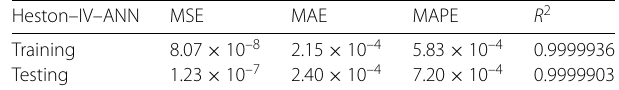
Table 4 The trained forward pass performance. The default float type is float32 on the GPU. The measures are defined as follows: MSE = 1 represents the true value, and ˆ y represents the predicted value with n being the number of